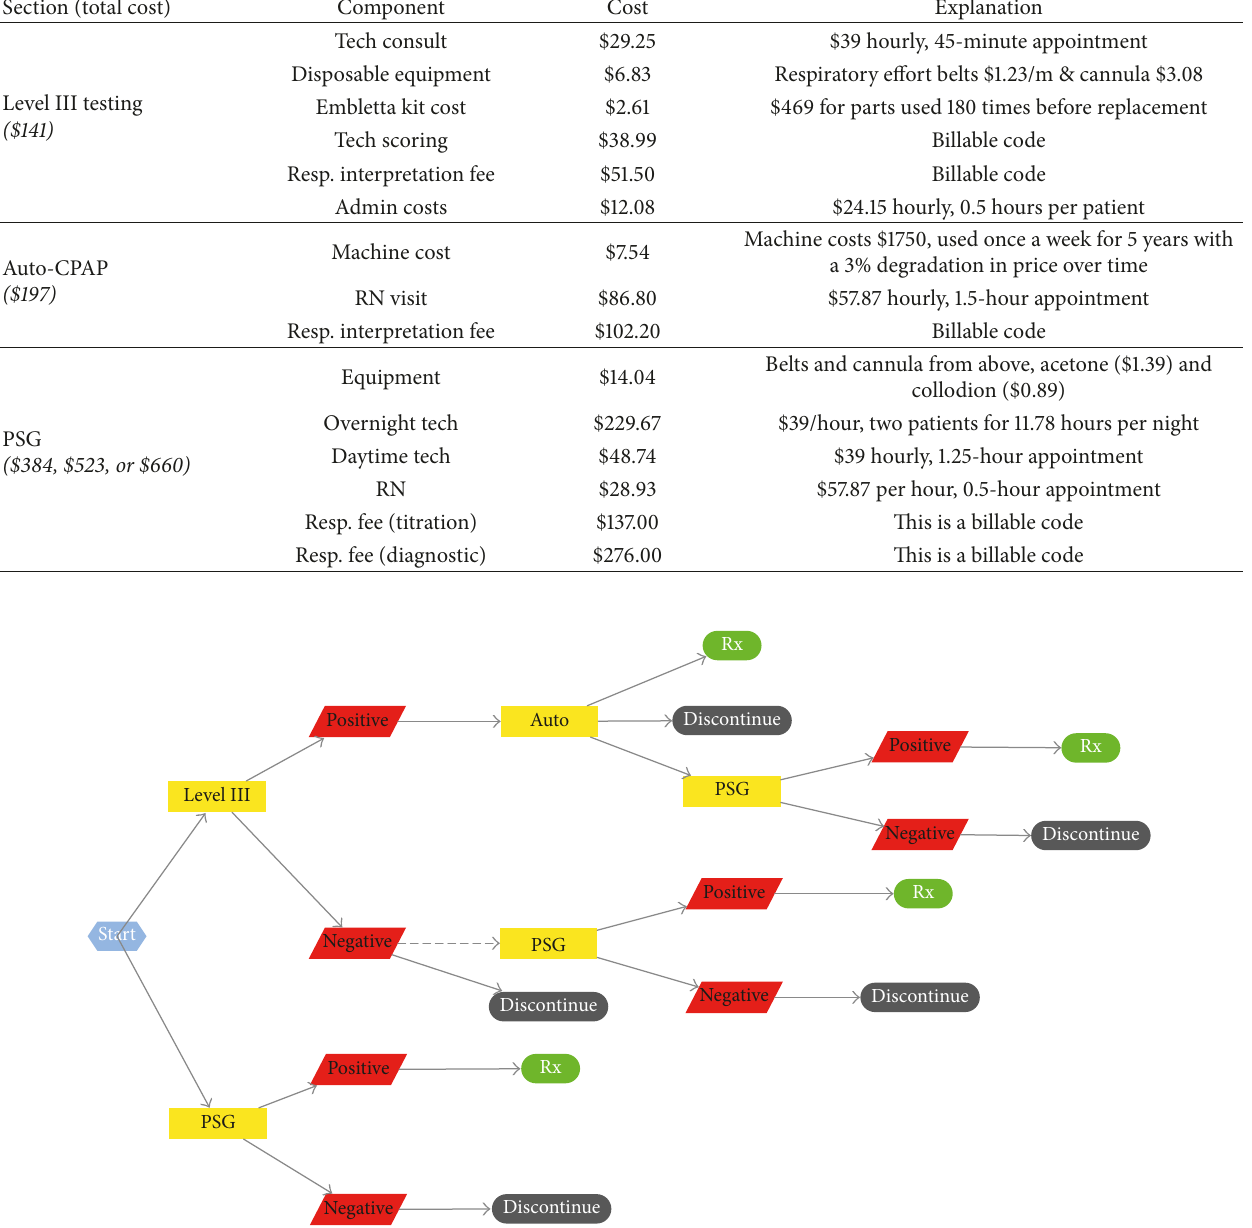
Figure 1: Theoretical patient flow within the sleep lab